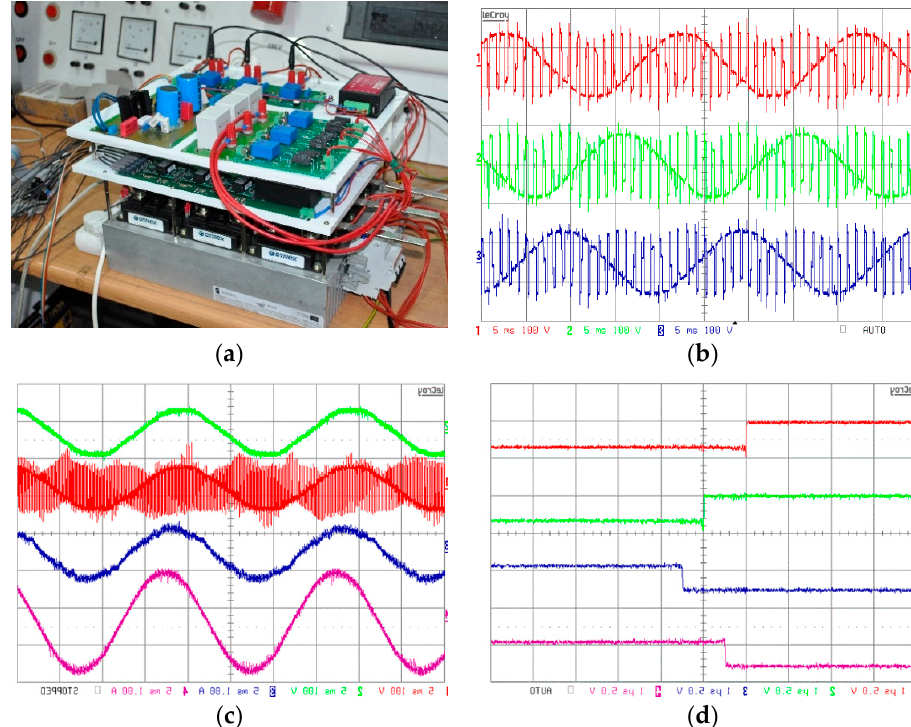
Figure 4. Low-power prototypes of Matrix Converter, ( a ) photo of power stage, ( b ) selected wave- forms of three phase voltages, ( c ) selected waveforms of grid and loads voltages as well as source and loads currents, ( d ) transistor control waveforms for four-stage current commutation.